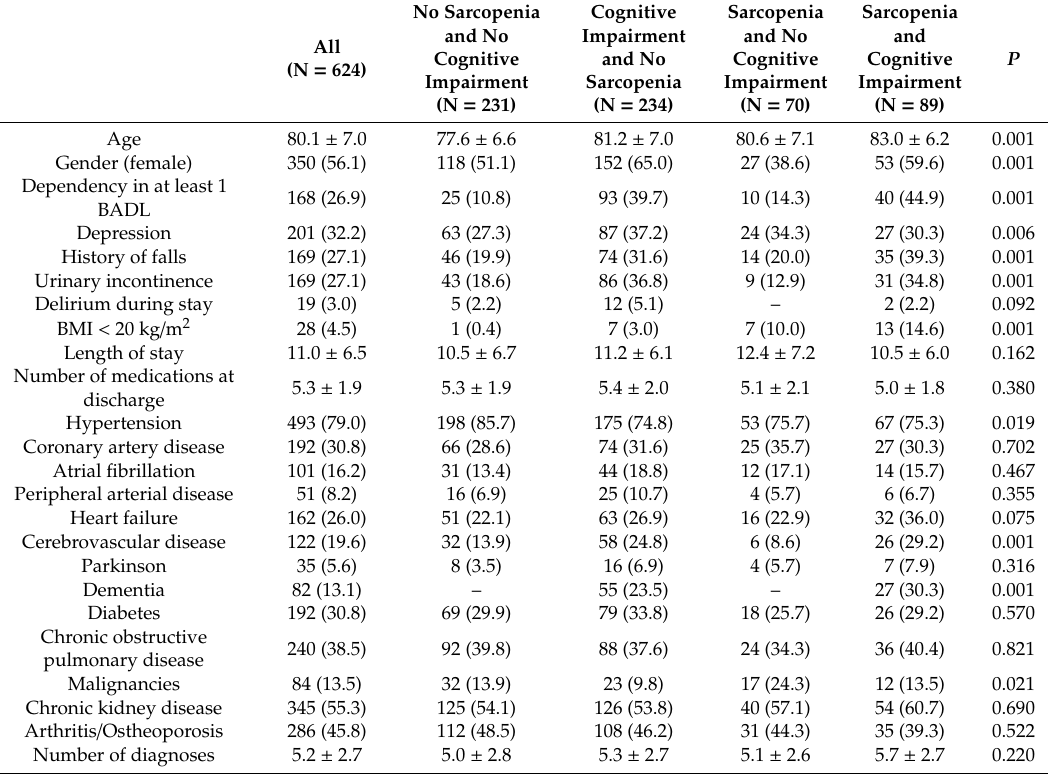
Table 1. Demographic and clinical characteristics of patients grouped according to the occurrence of sarcopenia, cognitive impairment, or sarcopenia and cognitive impairment.